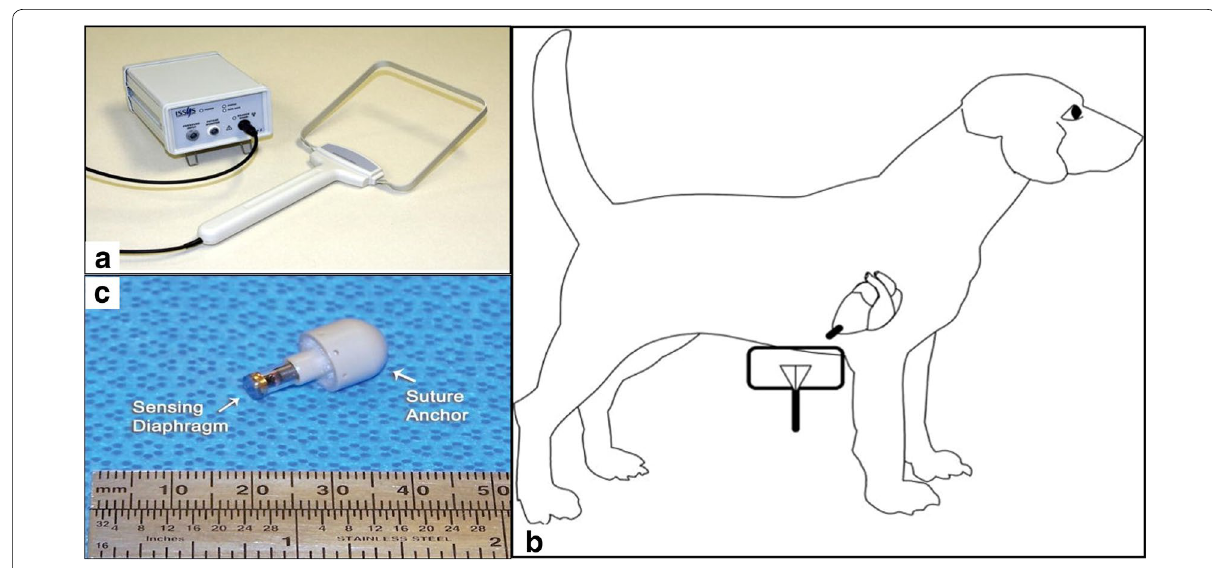
Fig. 8 a Proprietary transceiver unit and a handheld antenna. b Diagram implanted in apex of left ventricle. c Pressure sensors made with MEMS technology and electronic components providing signal conditioning, power management and radio frequency transmission are encapsulated in glass encapsulation devices (Reproduced with permission from Ref. [53], Copyright © 2012 by the American Society for Artificial Internal Organs)